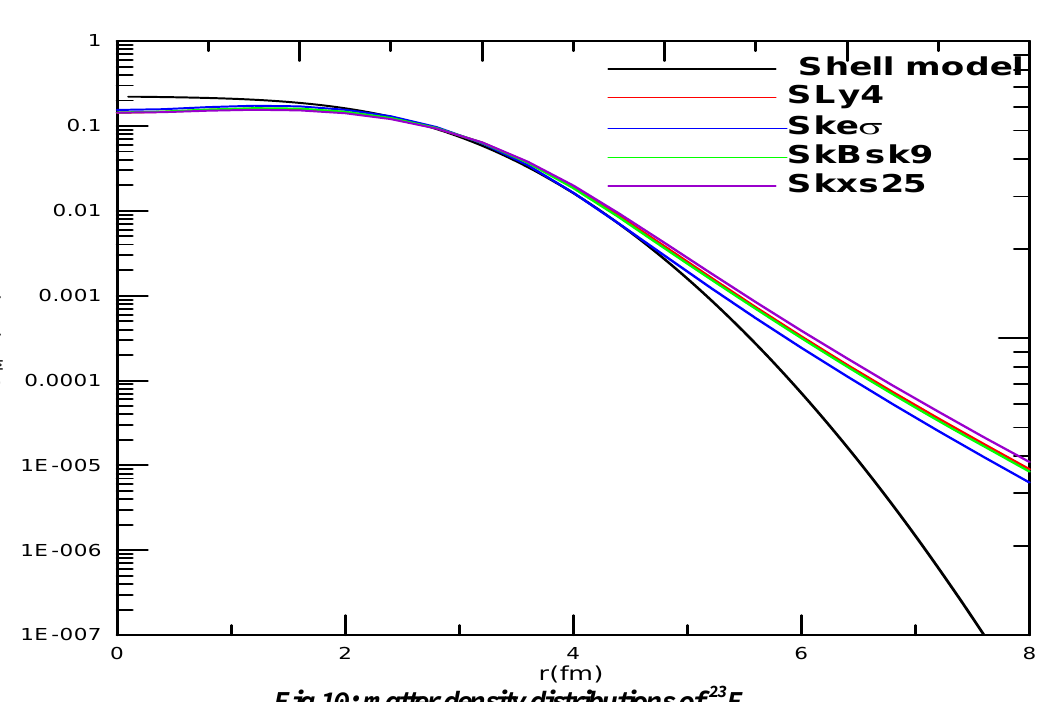
Fig.9: matter density distributions of 21 F .